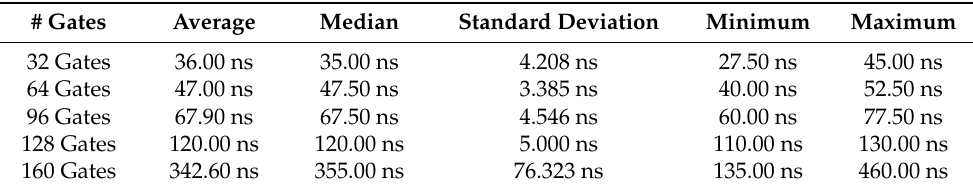
Table 2. Comparison between times for signal propagation for networks with unpowered gate ICs.